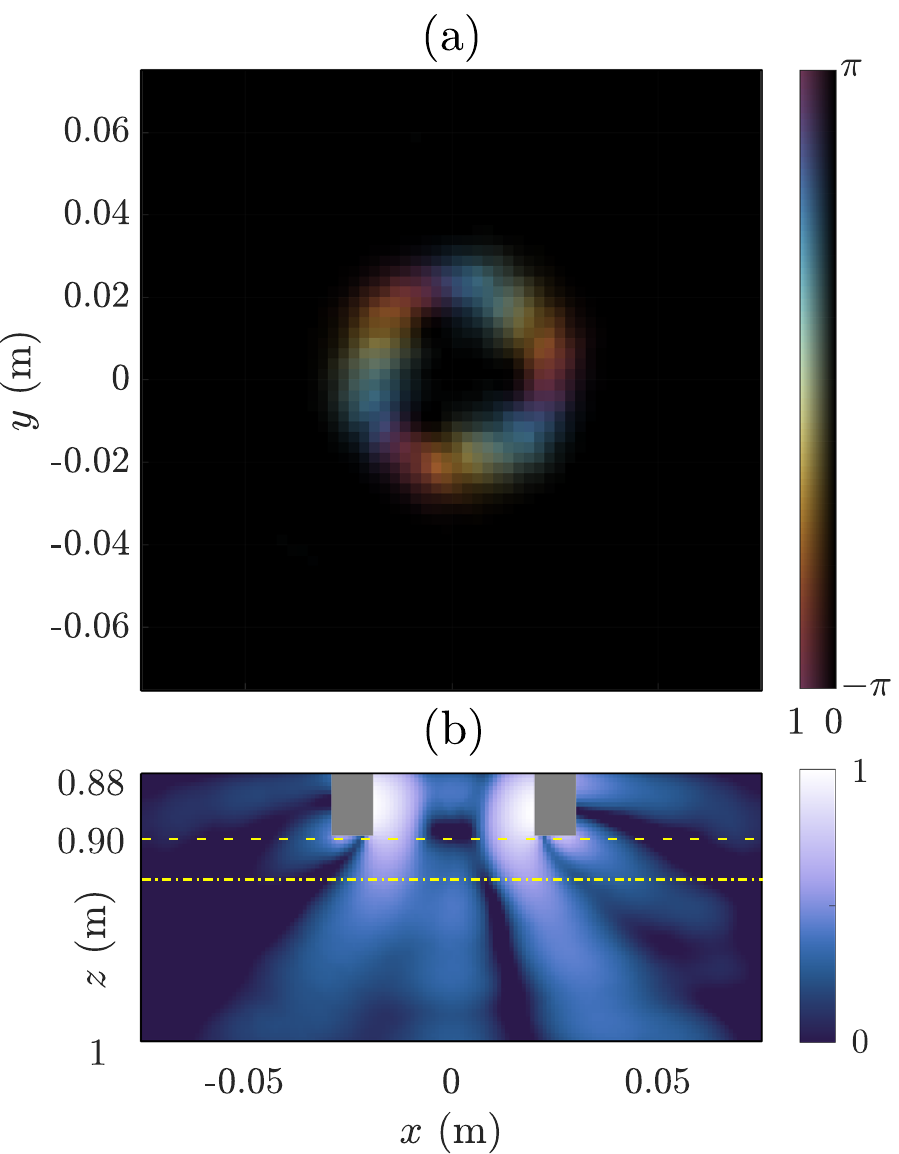
Fig. 3 FEM simulation on the effect of measurement depth. Fourier analysed time domain simulation with a Intensity (hue) and phase (colour) showing typical “ doughnut ” acoustic beam indicative of OAM at a plane close to the pipe end (1 mm below). b Normalised acoustic Intensity along x − z plane ( y = 0): data extracted along the dashed yellow line is used in a and the dash-dotted line in Fig. 2a, b (20 mm below the pipe). The acoustic vortex is obscured at the lower plane due to interaction with other modes present in the pipe, the cross-section of which is shown by the grey